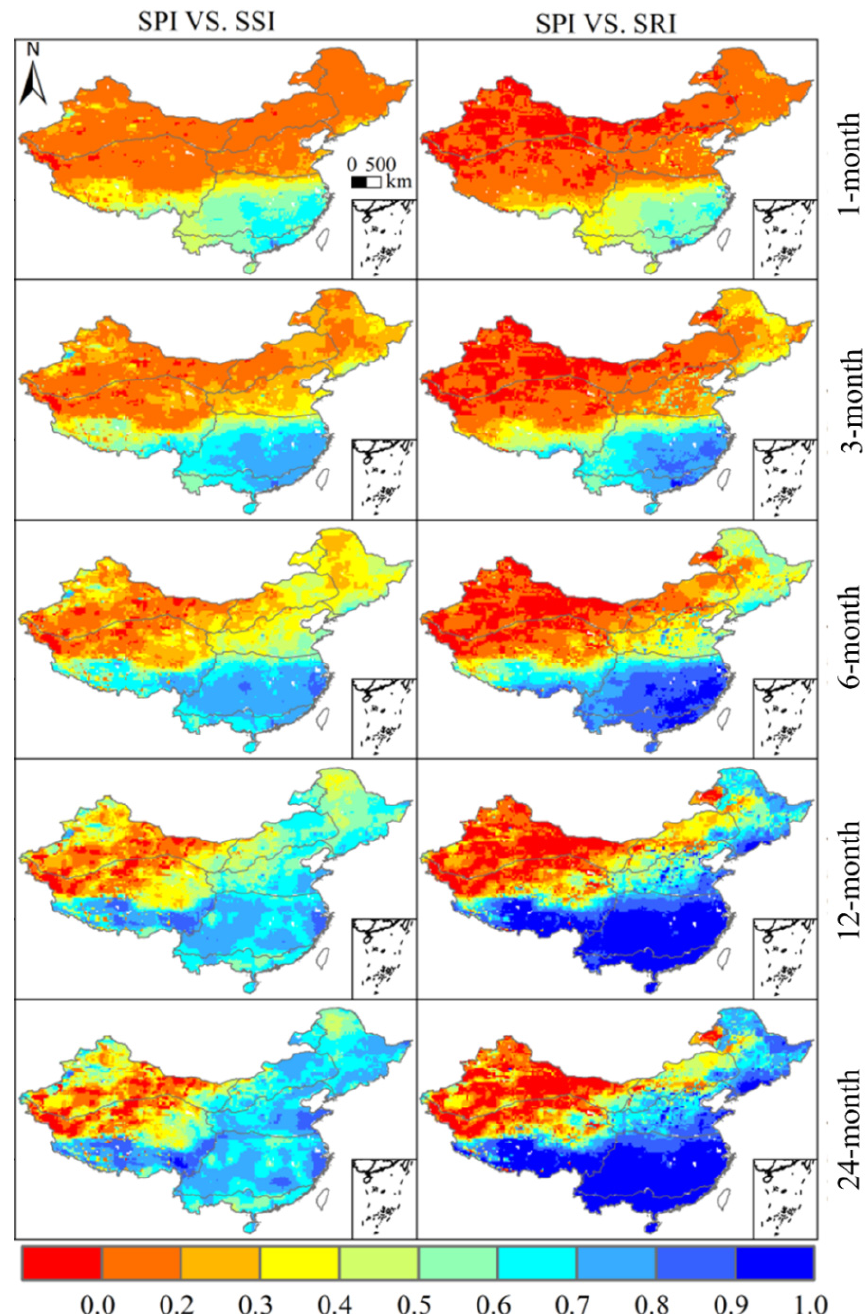
Figure 11. The spatial distributions of r values between SPI and SSI (or SRI) over 1948–2010 at the 1-, 3-, 6-, 12-, and 24-month timescales in mainland China. The detail comparison of the r values between SPI and SSI (or SRI) in different sub-regions are presented in Table 4. Table 4. The averaged r values of between SPI and SSI (or SRI) at different timescales in seven sub- regions of China. Sub-Region Timescale (Month) Drought Index